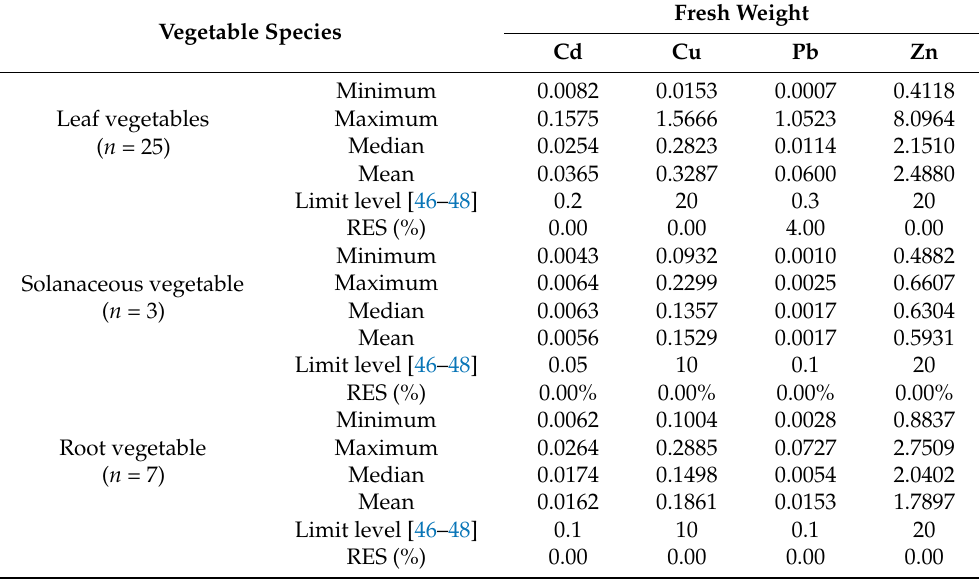
Table 3. Concentrations of heavy metals in the vegetable samples ( n = 35, fresh weight, mg · kg − 1 ). Vegetable Species